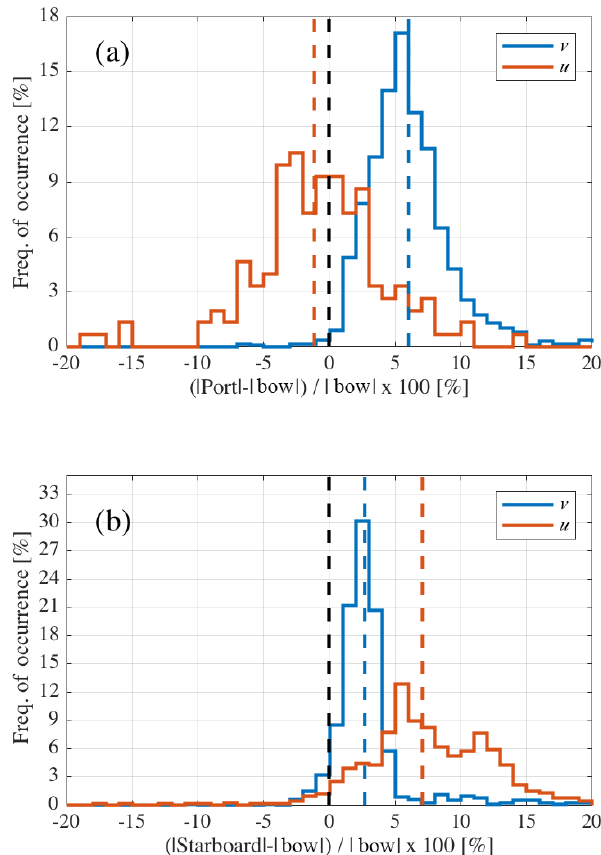
Figure 18. Distributions of the percent error in the (a) port and (b) starboard bridge sonic anemometers relative to the bow-mast sonic during CalWater-2. The data are the same as in Fig. 14, with u defined as relative wind directions 210–330 and 30–120 ◦ and v defined as relative wind directions 330–30 ◦ , but here they are shown normalized by wind speed to illustrate the source of the correction factors (denoted by the colored vertical-dashed lines) that are re- ported in the